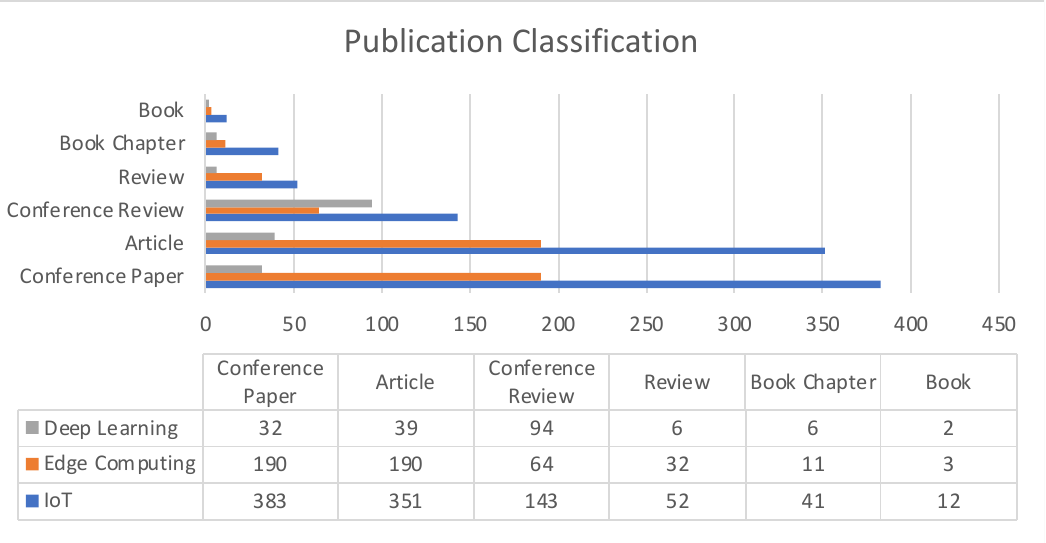
Figure 17. Publication classification comparison for Allied Technologies. Figure 18 represents the region-wise publication distribution for works concerning the use of Blockchain–Cloud integration along with the IoT. China and India are leading from the front, followed by the United States.